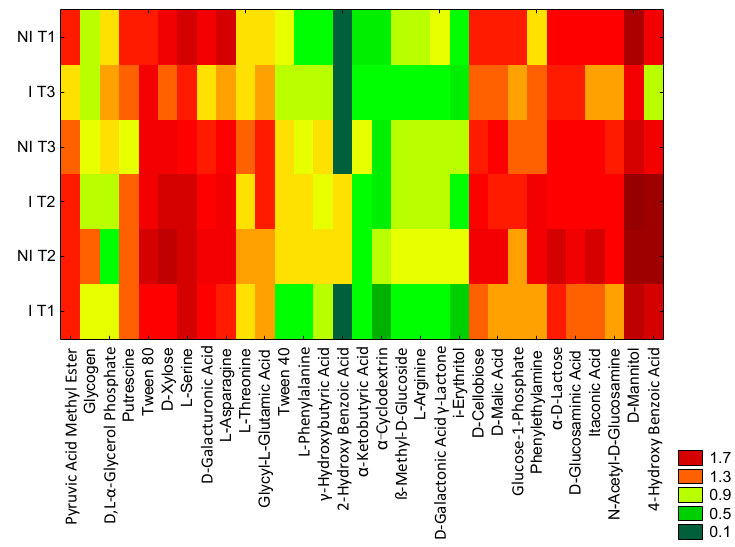
Figure 3. Biolog EcoPlate TM carbon substrates utilization intensity diagram. NI, non-inoculated; I, inoculated with Rhizobium ; T1, 5–6 leaf stage; T2, flowering; T3, pod formation stage; n = 3.